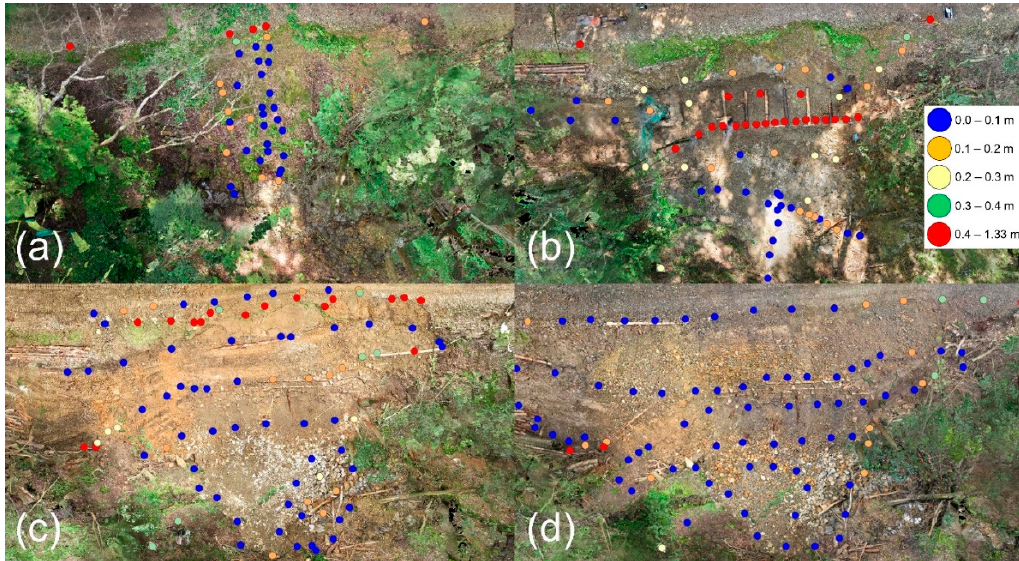
Figure 5. Absolute values of the error at each process of the repair work. ( a ) before the repair work, ( b , c ) during the repair work, ( d ) after the repair work.